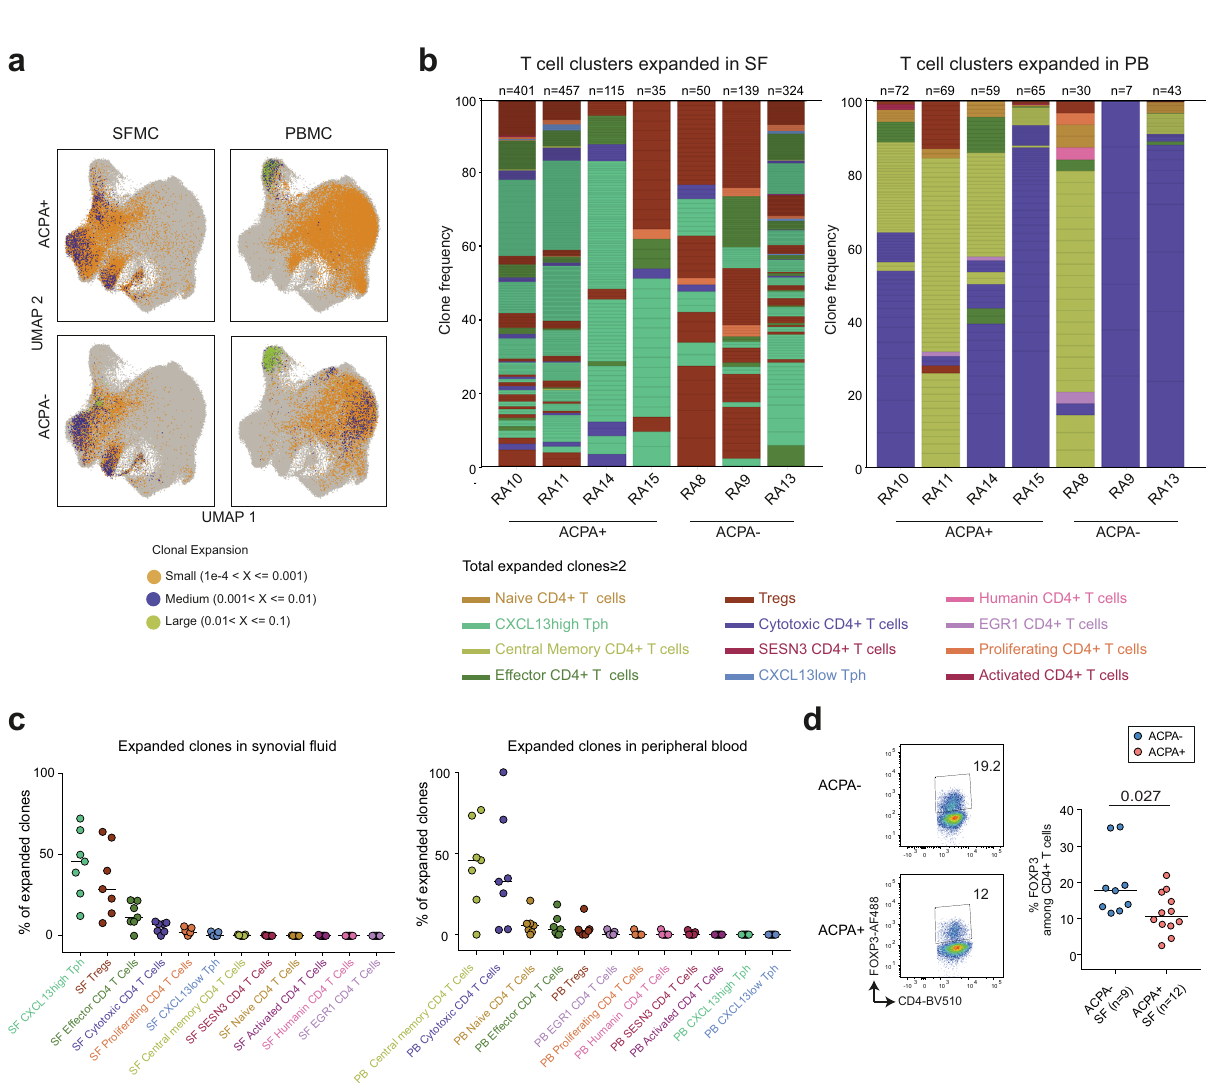
Fig. 5 Clonally expanded CD4 + T cells in RA. a UMAP plots showing expanded clones in ACPA + ( n = 4) and ACPA − ( n = 4) RA PB and SF, colored based on sample size. Orange dots indicate small clones (1e-4 < X ≤ 0.001), purple dots indicate medium size clones (0.001 < X ≤ 0.01), green dots indicate large size clones (0.01< X ≤ 0.1). Each dot displays a cell. b Stacked barplots displaying the phenotype of the SF (left) and PB (right) expanded clones ( n ≥ 2 cells) in each RA patient, quadrant represents an individual clone, total number of clones per patient are indicated above each column. c Frequency of expanded clones within each CD4 + T-cell cluster in SF (left panel) and PB (right panel) for each RA patient ( n = 4 ACPA + , 3 ACPA − ). d Frequency of FOXP3 + cells among CD4 + T cells in ACPA − ( n = 9) and ACPA + ( n = 12) RA SF, P = 0.027. Data are from a pool of nine independent experiments where a circle is a single replicate. Blue dots indicate ACPA − RA SF and red dots indicate ACPA + RA SF. Line represents median, two-tailed Mann – Whitney U